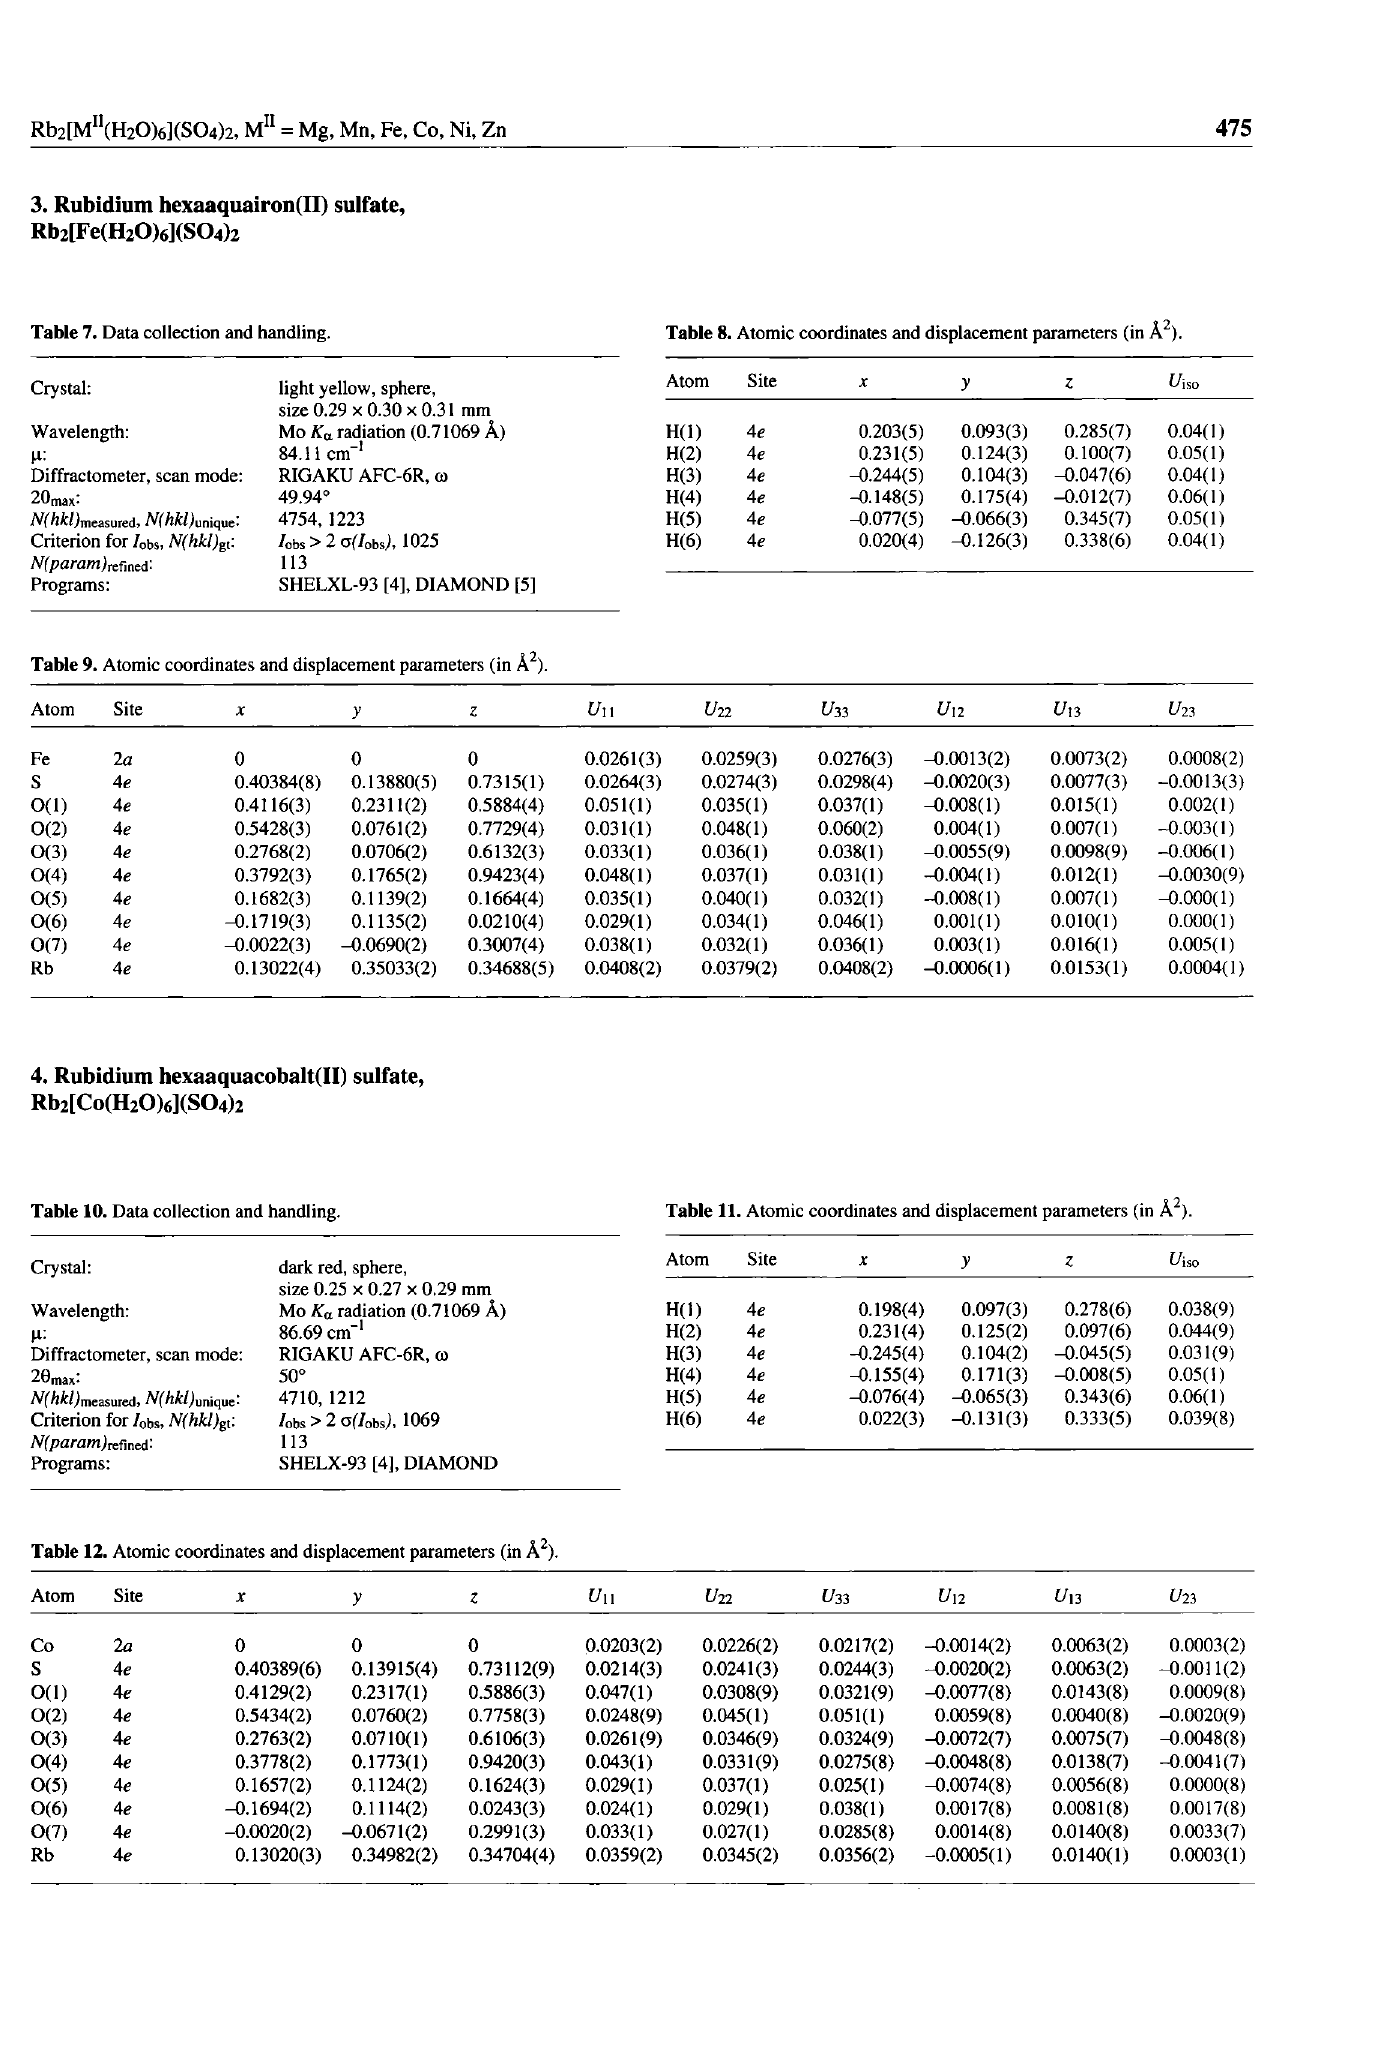
Table 12. Atomic coordinates and displacement parameters (in A 2